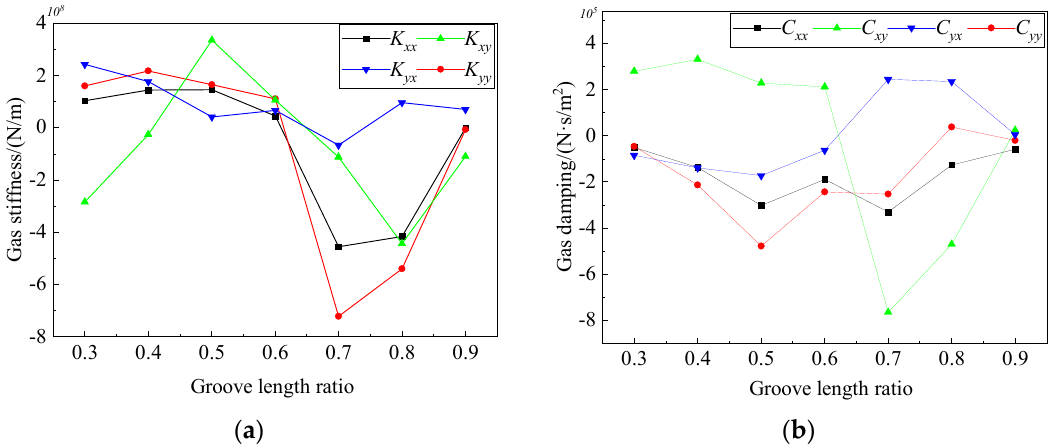
Figure 9. The effect of groove length ratio on the rotodynamic coefficients. ( a ) The effect of groove length ratio on gas stiffness; ( b ) The effect of groove length ratio on gas